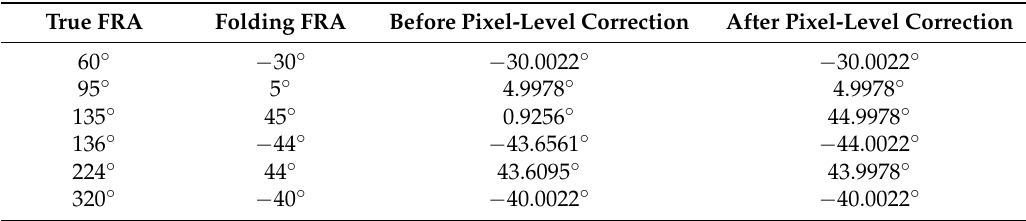
Table 2. FRA estimates for different true values larger than 45 ◦